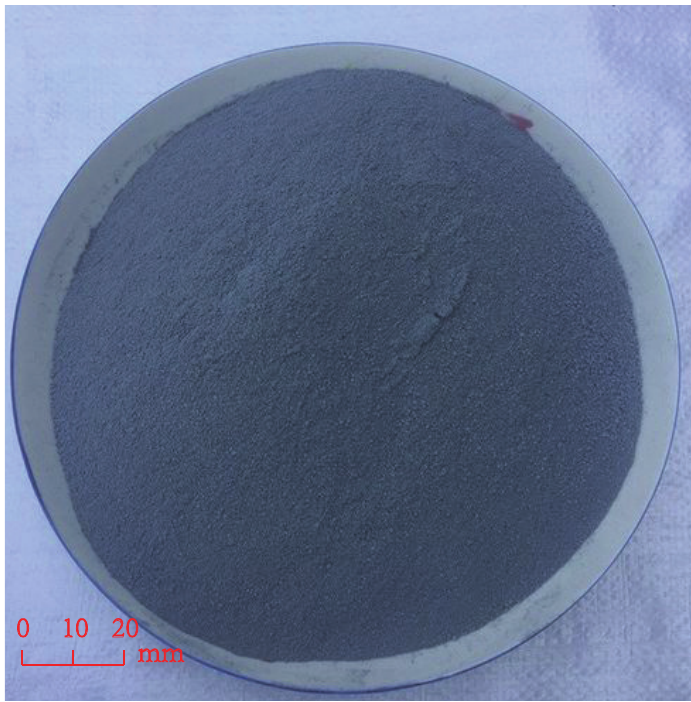
Figure 3. Appearance of silica fume.